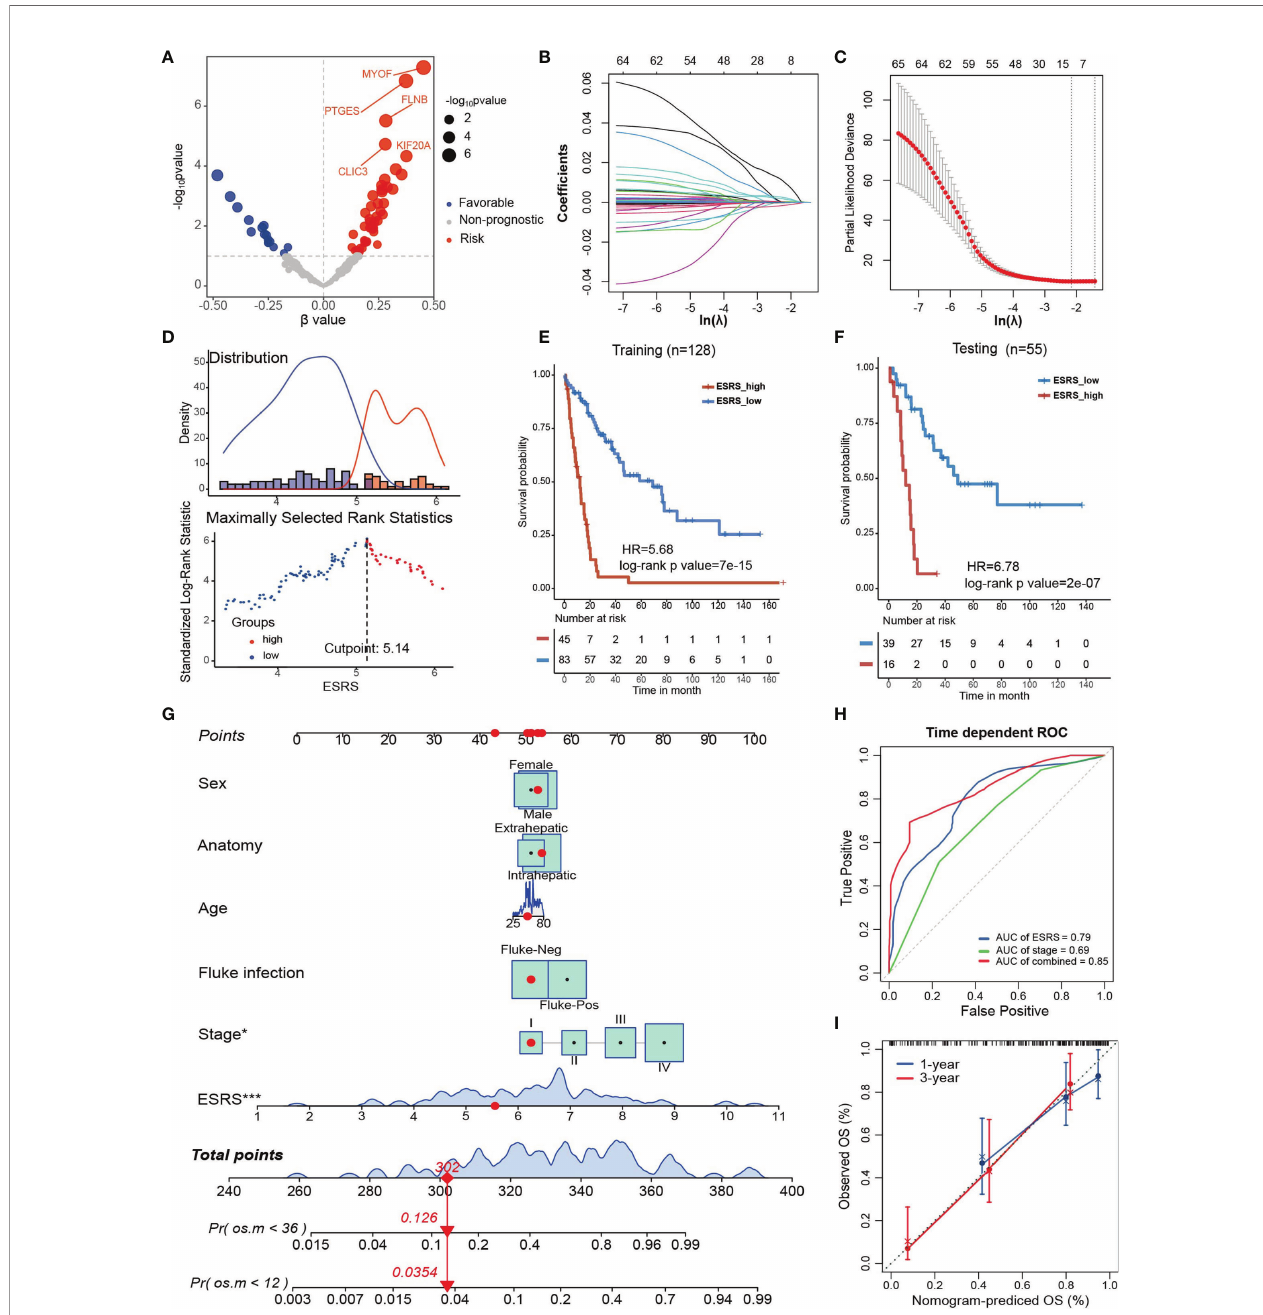
FIGURE 5 | Establishment and validation of the estrogen response-related score (ESRS) in CCA patients. (A) Volcano plot showing the univariate Cox regression results of the estrogen response-related genes in the meta-cohort. The horizontal coordinate represents the coef fi cient of univariate Cox regression, and the vertical coordinate represents the -log10p value of univariate Cox regression. (B) With a fi ltering threshold of a P value less than 0.1, 65 candidates remained and were entered into the LASSO Cox regression model. (C) Tenfold cross-validation for tuning parameter selection in the LASSO model. The dotted vertical lines are drawn at the optimal values by minimum criteria (lambda.min, left vertical dotted line) and 1-SE criteria (lambda.1 se, right vertical dotted line). (D) The best cutoff value of ESRS was chosen by maximally selected rank statistics. (E) Kaplan – Meier analysis demonstrated that patients with higher ESRS exhibited worse prognosis in the training cohort (HR = 5.68, log-rank p value = 7×10 -15 ). (F) In the testing cohort, Kaplan – Meier analysis showed that patients with higher IRS exhibited worse prognosis (HR = 6.78, log-rank p value = 2×10 -7 ). (G) A personalized scoring nomogram was generated to predict 3- and 5-year OS probability with the seven parameters, and the red arrow shows an example. (H) Time-dependent ROC analysis demonstrated that combining ESRS and stage information could better predict the 5-year OS probability. (I) Calibration curves of 1-year and 3-year OS prediction were close to the ideal performance (45-degree line). Statistical p-value (*,P < 0.05; ***,P <